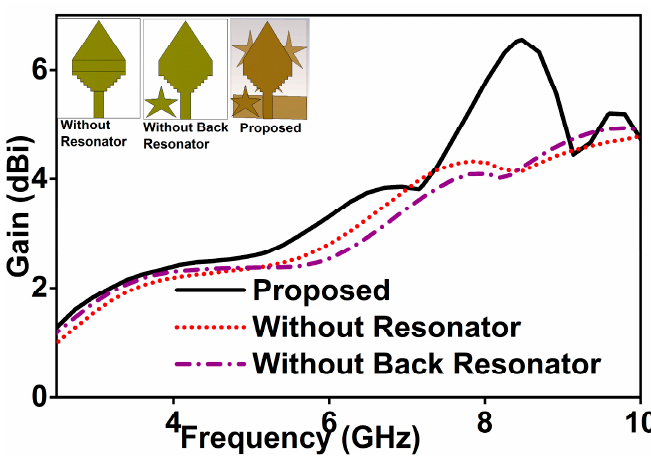
Figure 3. E ff ects of the parasitic resonator to the gain of the Figure 3. Effects of the parasitic resonator to the gain of the antenna.